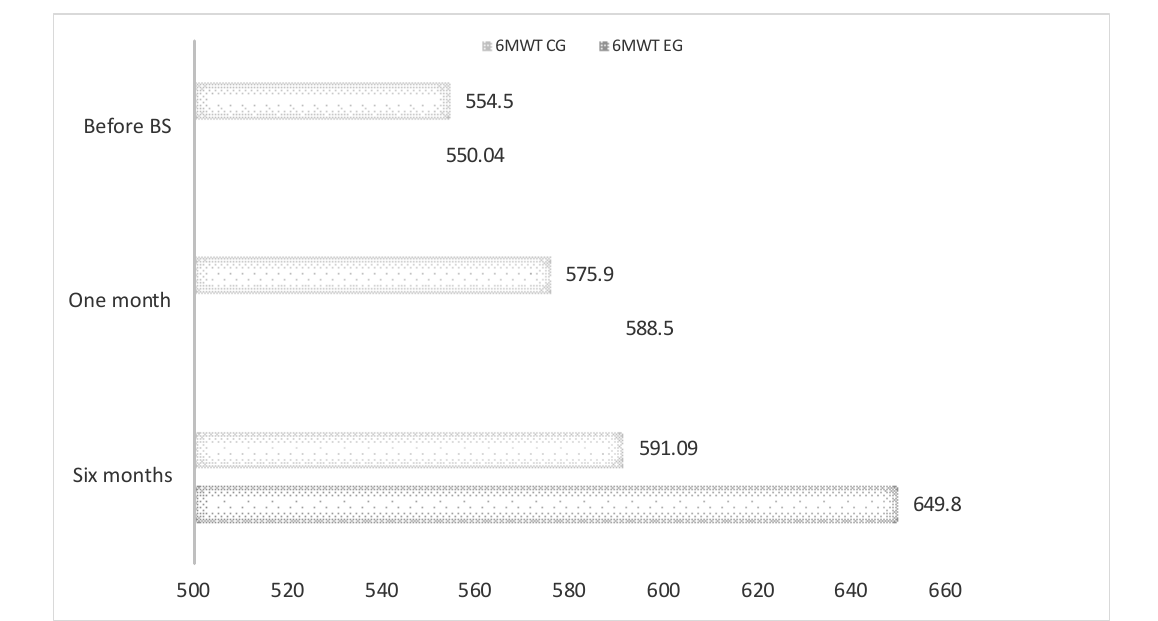
Figure 2. 6MWT mean walked distances. Walked distances showed in m. ANOVA of repeated measures revealed significant time-group interactions for BMI (F = 14.60; p < 0.0001) and 6MWT (F = 20.44; p < 0.0001). Multiple comparisons results are presented in Table 3. Table 3 . Intragroup and Intergroup Multiple Comparisons.